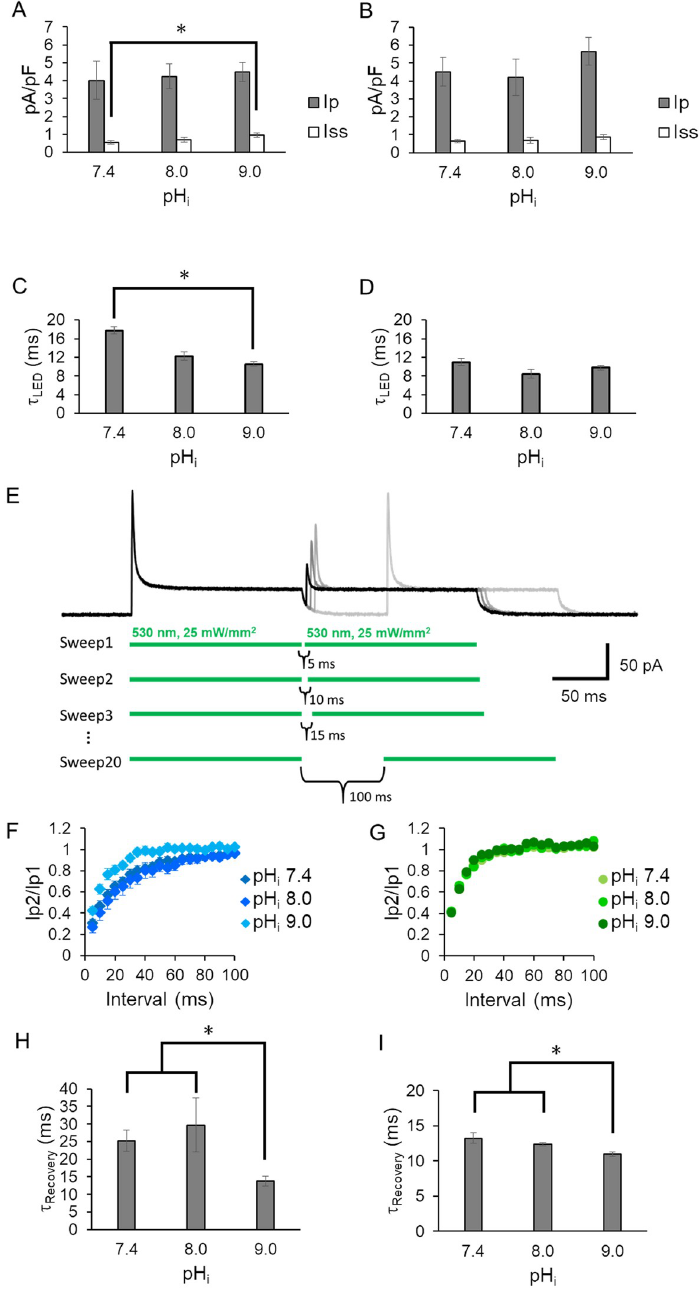
Fig 2. Effect of intracellular pH (pH i ). Photocurrent amplitude at 0 mV under three pH i conditions (7.4, 8.0 and 9.0) in the absence (A) and presence (B) of 110 mM NaCl inside (n = 6–14, � p < 0.05). The bath solution contained 140 mM NaCl at pH 7.4. See Table for more details. Gray bar: peak current (I p ); white bar: steady state current (I ss ). Off kinetics value ( τ off LED ) under 3 pH i conditions in the absence (C) and presence (D) of 110 mM NaCl in intracellular solutions. E, Representative KR2 photocurrent in double pulse experiment with various dark periods at 0 mV. LED light at 530 nm was applied as indicated by green lines below the photocurrent traces. The dark interval between the two light pulses was prolonged by 5 ms. Photocurrents traces are overlaid in different gray scales. The second peak amplitude was recovered as the dark interval was prolonged while the steady state current remained unchanged. The inter-sweep dark period was always set at 2.0 s to guarantee completed dark adaption. The intracellular solution contained 110 mM NaCl at pH 7.4 while the bath solution contained 140 mM NaCl at pH 7.4. D, Time course of the second peak recovery (n = 6–22) (F and G). The second peak ratio (Ip2/Ip1) was plotted as a function of the dark period (ms). F,